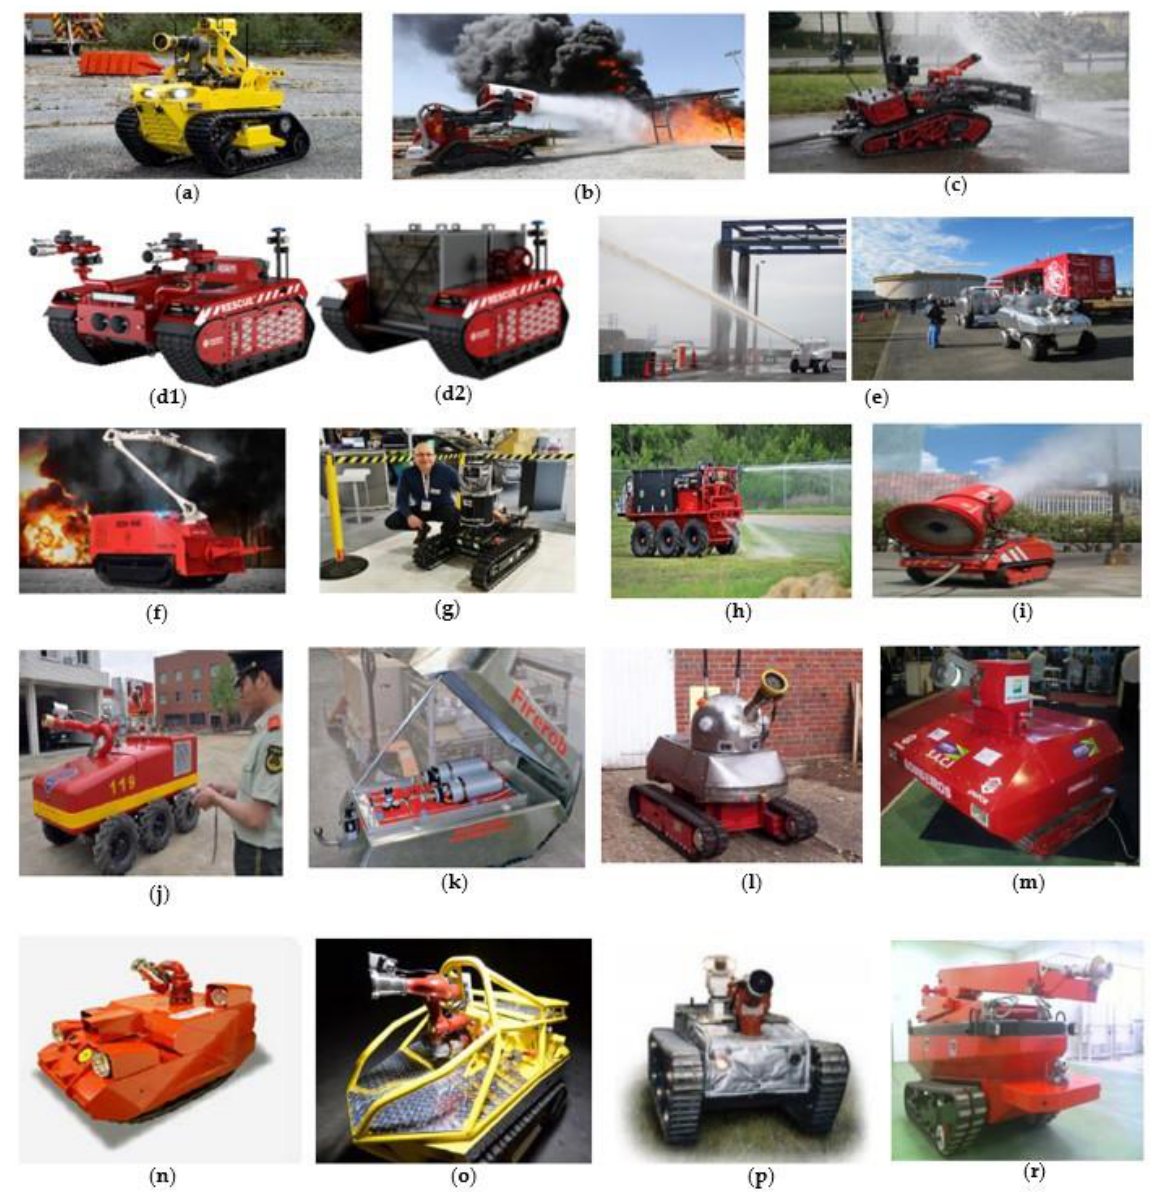
Figure 1. Firefighting robots ( a ) Termite RS1/RS3 [23,24] ( b ) TAF35 [25] ( c ) Colossus [26] ( d1 )